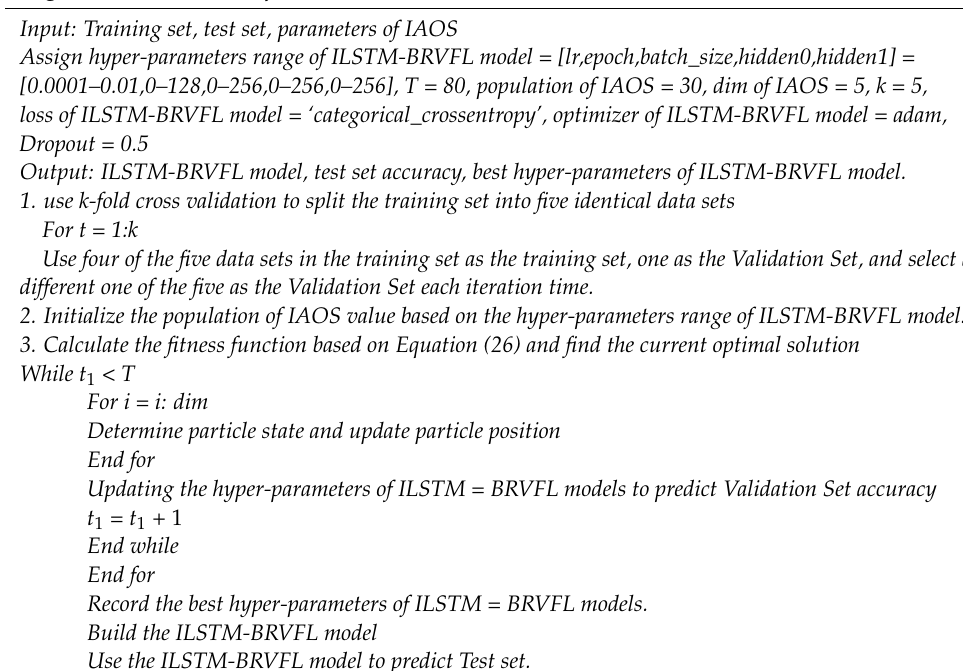
Algorithm 4 Pseudocode